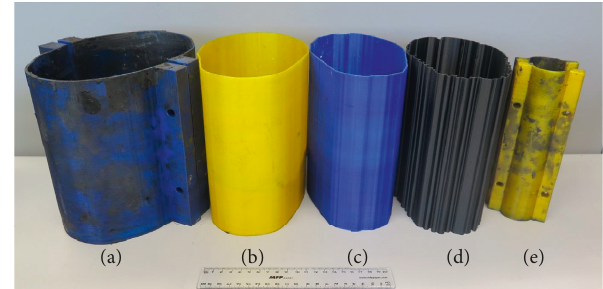
Figure 3: Molds printed in 3D for human head phantom fabri- cation: scalp (a), skull (b), CSF (c), gray matter (d), and stroke model (e).